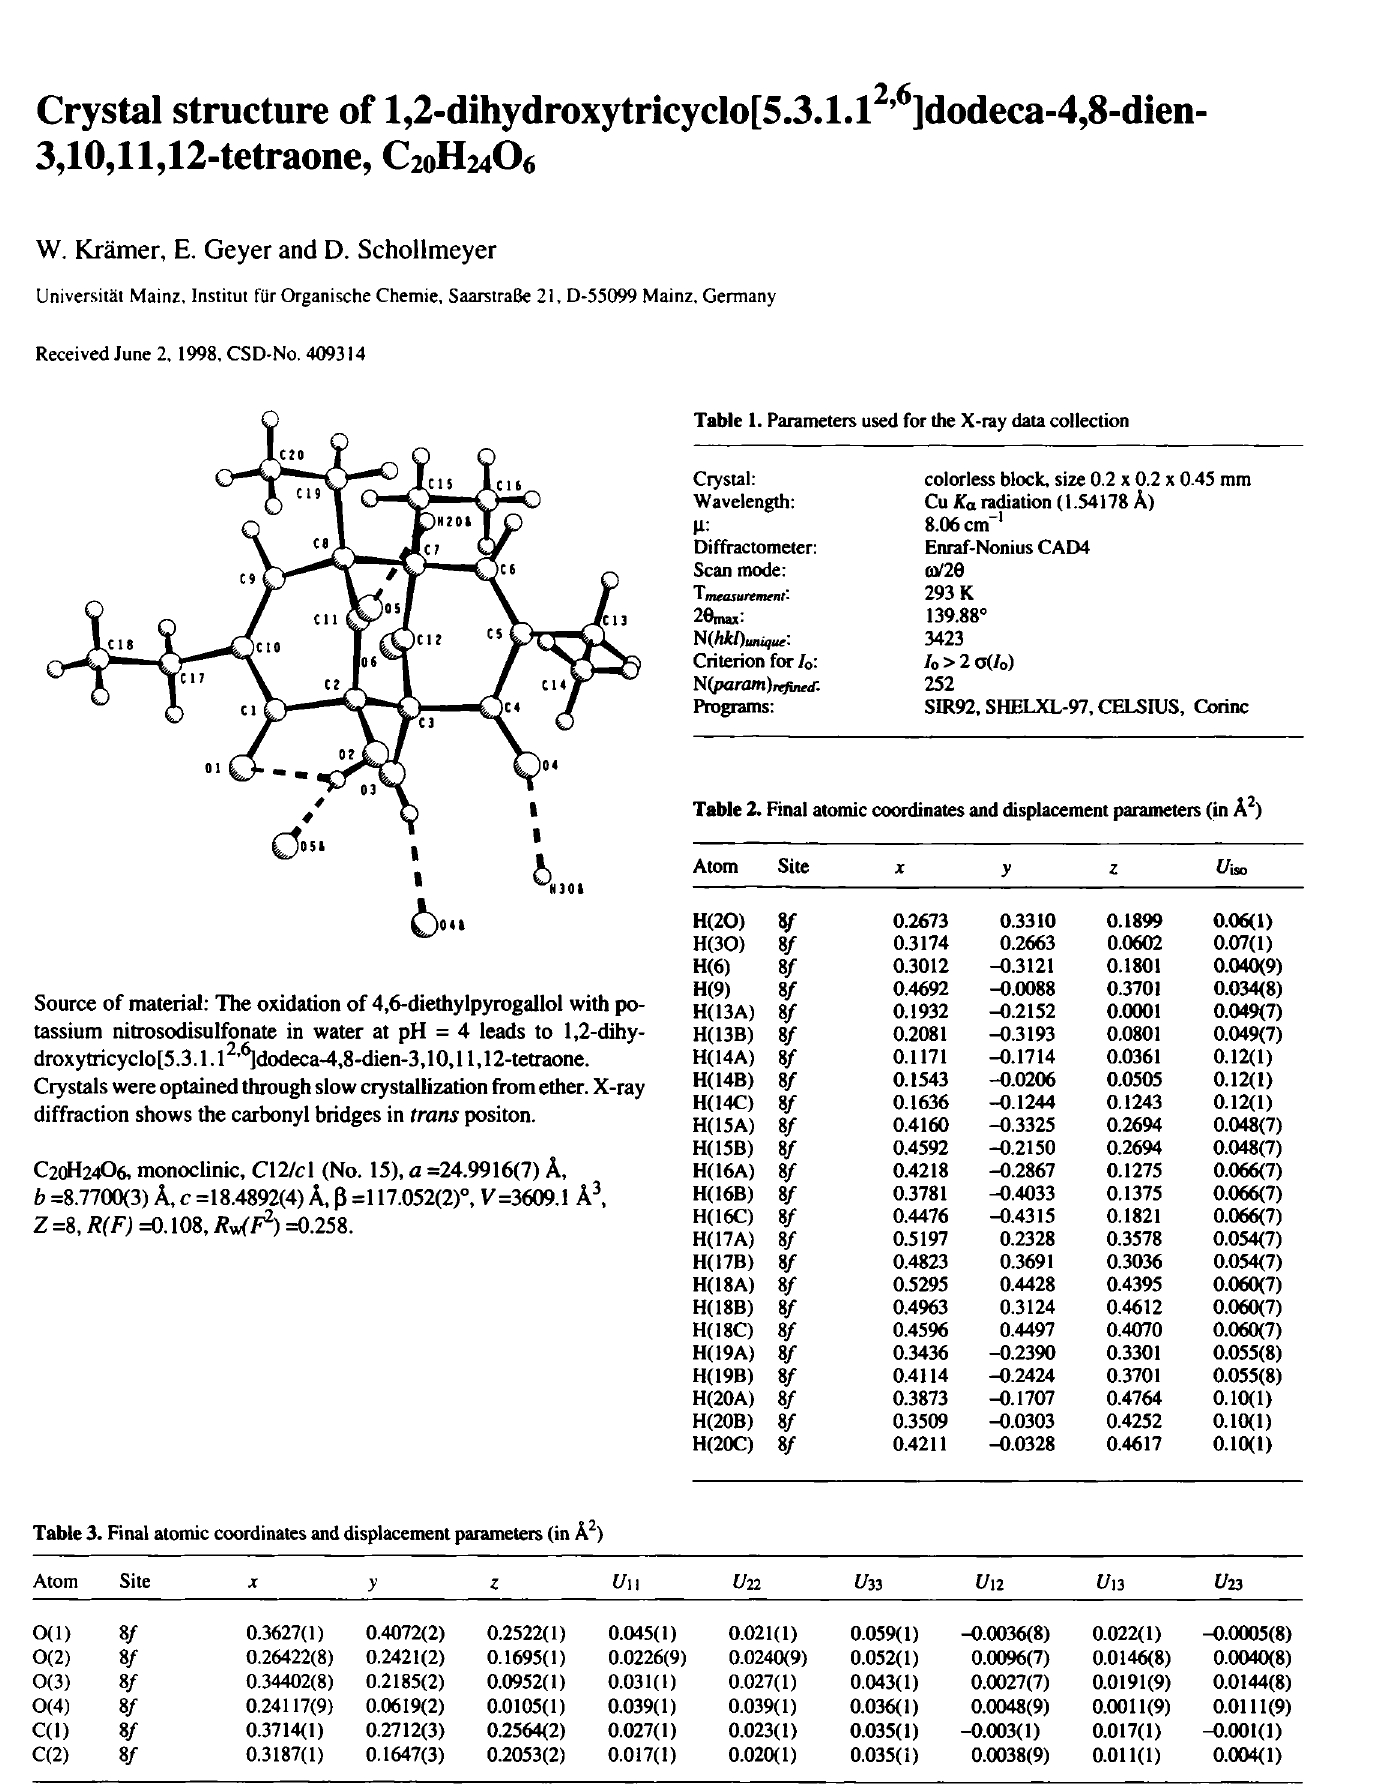
Table 3. Final atomic coordinates and displacement parameters (in Â^) Atom